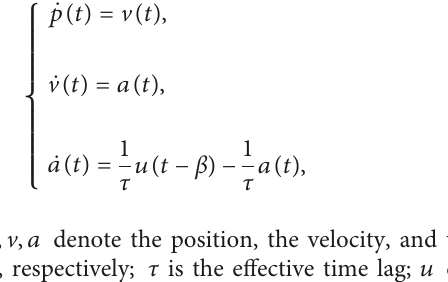
Figure 2: The control block diagrams of these two architectures.